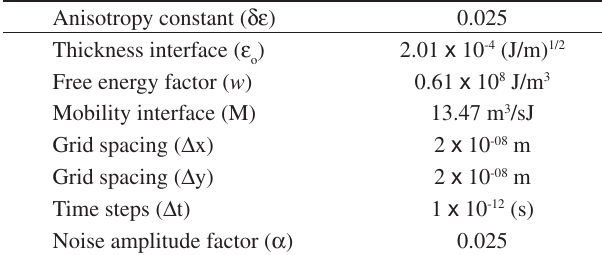
Figure 2. Dendrite calculated with a 1200 x 1200 point grid, where the den- drite started to grow from a seed at the top left-hand corner toward the bottom right-hand corner of the box. Solidification time was 6.26 x 10 -7 Table 3. Parameters model (Ni) 6 .